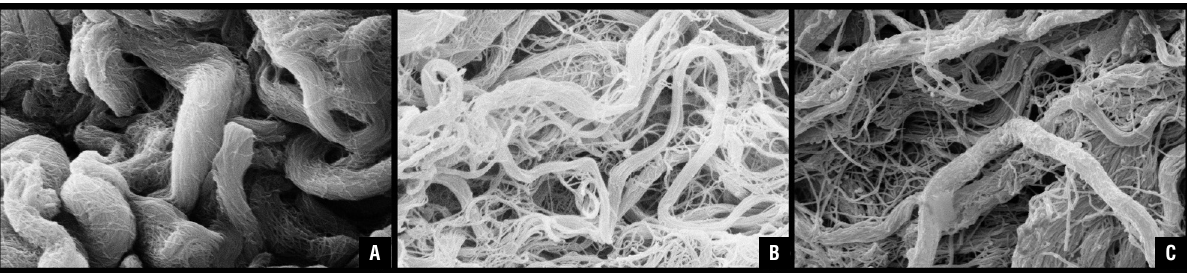
Figure 3 - Decellularized ventral prostate of rats observed under scanning transmission microscopy. In image A) (group Sham) we observe both thin and thick collagen fibers, compatible with types I and III, respectively. In image B) from group Orch, there is a predominance of type I collagen fibers, while image C) (group Orch+T) resembles what was observed in image A, with presence of both collagen